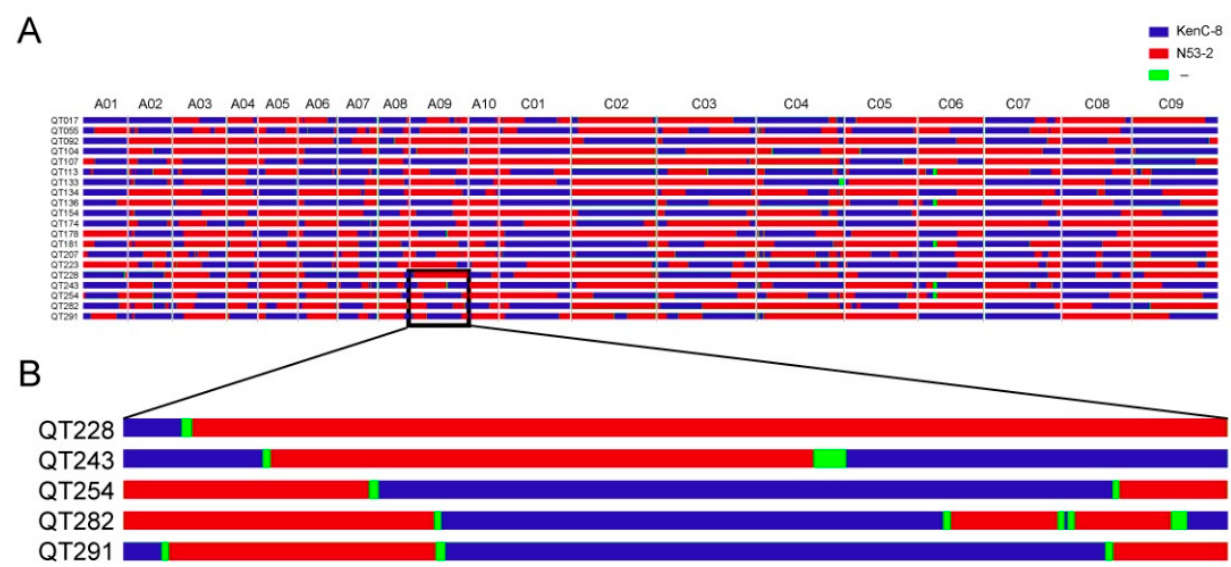
Figure 1. Detection of recombination bins in the KN DH population. ( A ) Recombination bins detection of 20 randomly selected lines in the KN DH population. Red intervals represent the male parent N53-2 genotype, blue intervals represent the female parent KenC-8 genotype, and green intervals indicate an undefined genotype. ( B ) Highly magnified chromosome A09 of five lines in Figure 1A.